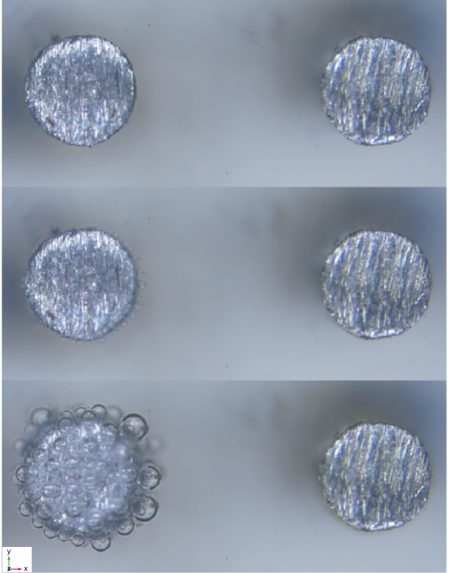
Figure 5. Bubble measurement photo-grams examples for 100 V assay.